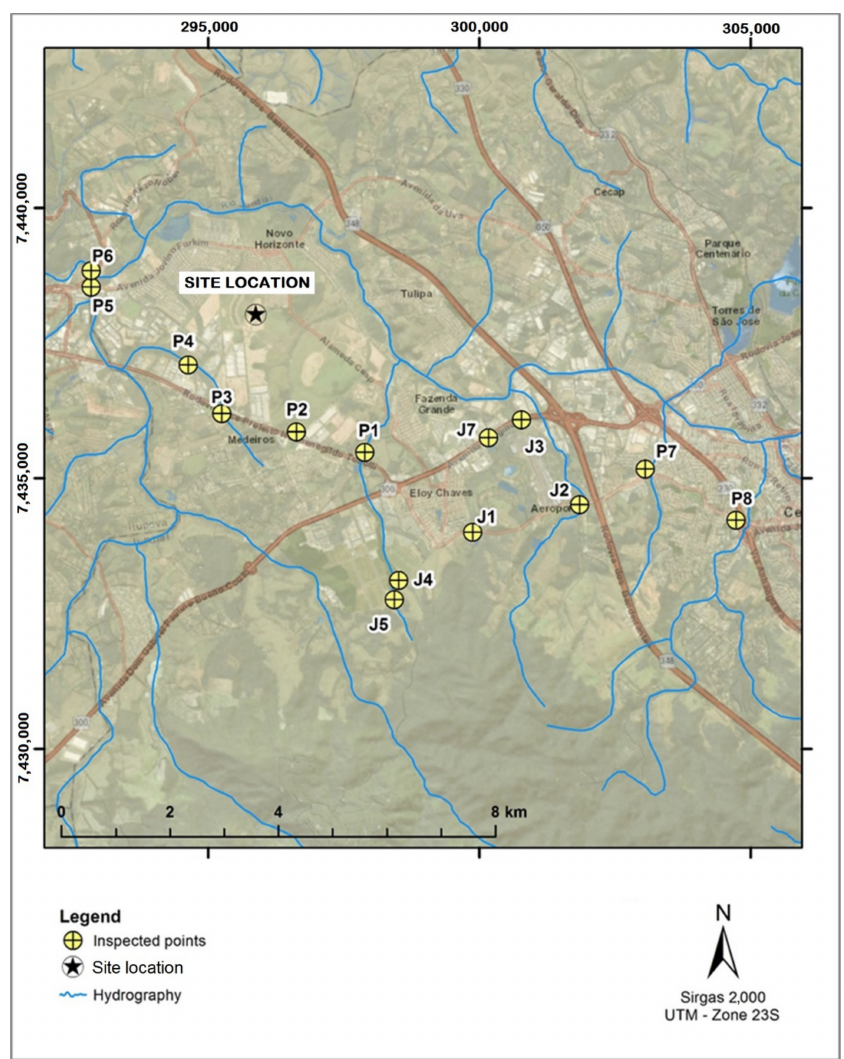
Figure 11. Localization of inspected